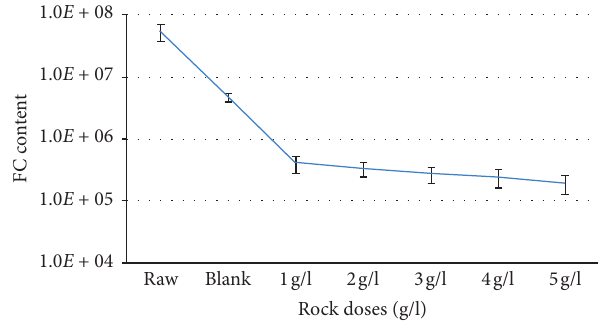
Figure 4: Variation of the FC count along with the treatment steps. Table 3: Complete analysis of the raw waste water and different treated